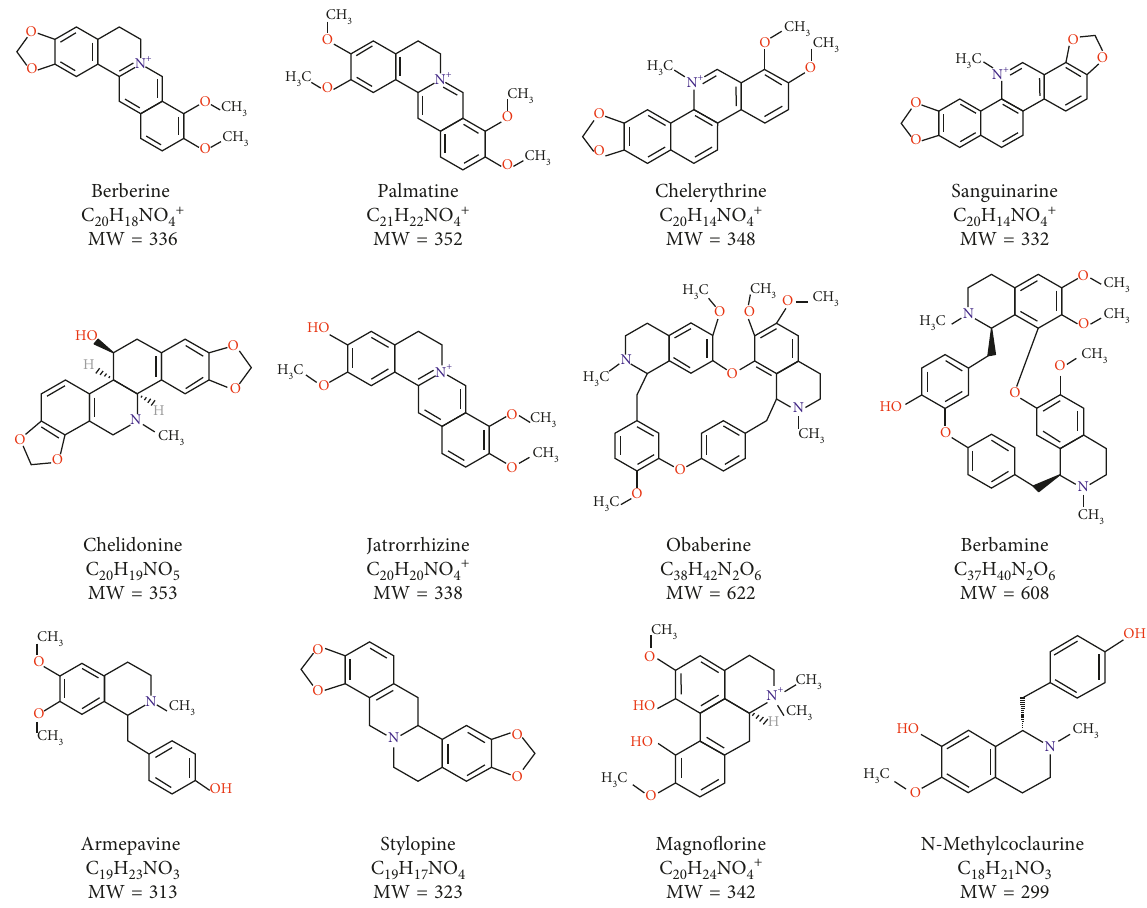
Figure 1: The chemical structures of the quantified isoquinoline alkaloids with their molecular weights and chemical formulas.